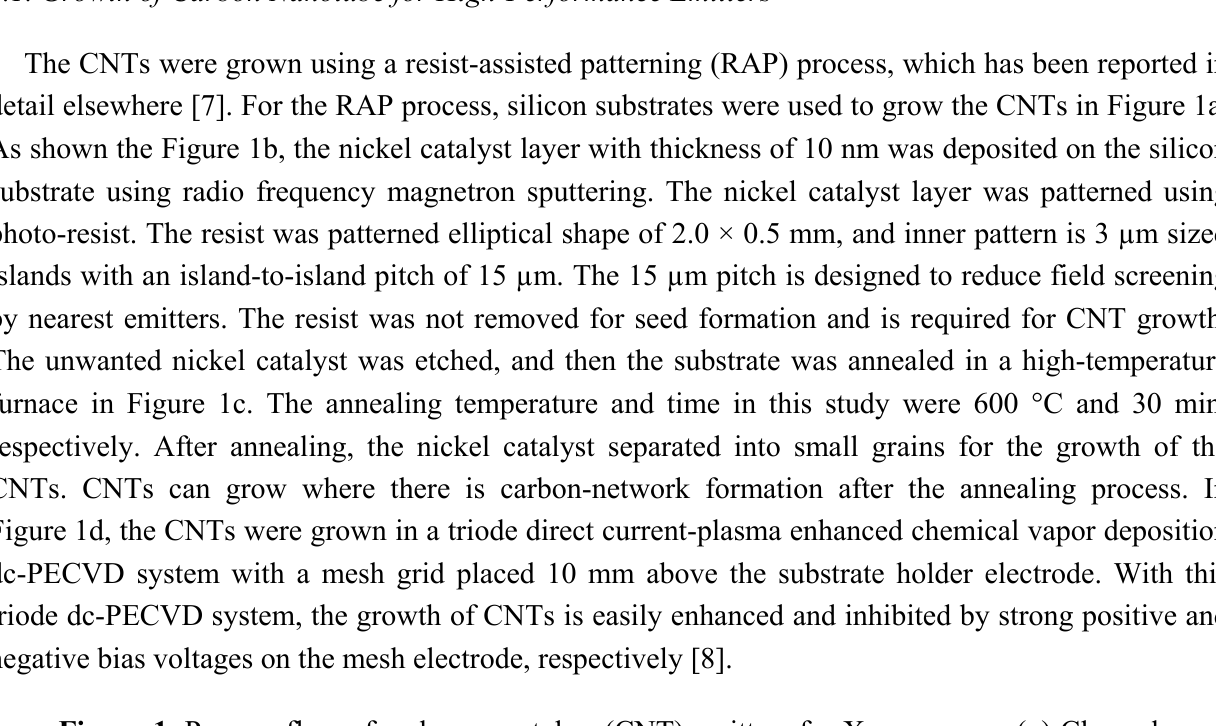
Figure 1. Process flow of carbon nanotubes (CNT) emitters for X-ray source. ( a ) Cleaned Si substrate; ( b ) Ni catalyst deposition; ( c ) Patterning and forming for seed formation; ( d ) CNT growth; ( e ) hydrofluoric (HF) treatment; ( f ) Electrical aging